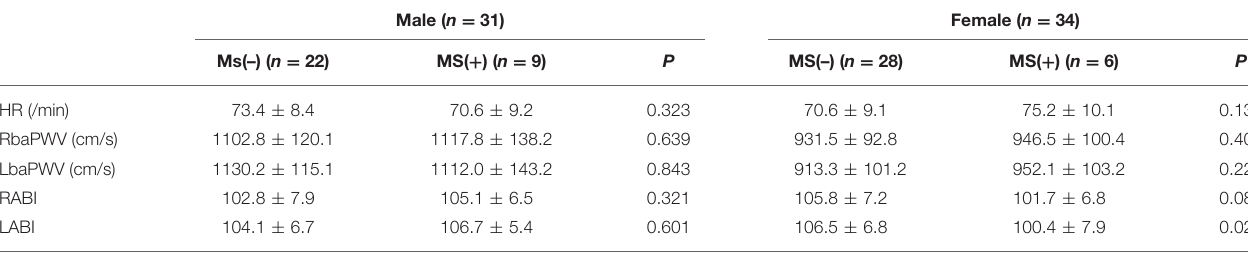
TABLE 7 | Comparison of pulse wave velocity and ankle brachial index in obese adolescents.